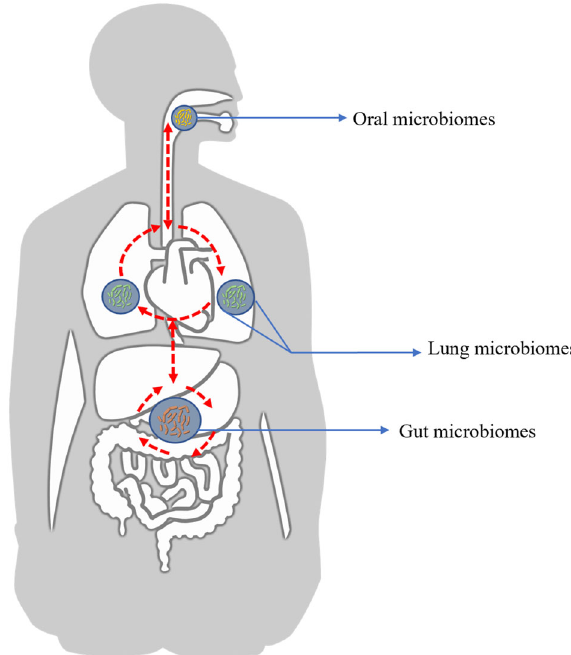
Fig. 1 Dynamic connections of microbiome inhabiting different human body sites. Oral, lung, and gut microbiome could commu- nicate with each other via direct manner including mucosal dispersion, respiratory and digestive activities, and indirect manner via in fl ammatory substances, cytokine, and metabolites in systema- tic circulation. Bacteria and its metabolites from intestinal tract modulate the differentiation tendency of naive T cells and Th17 release, modulating the systematic in fl ammation and